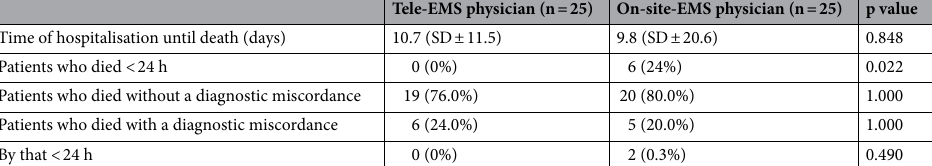
Table 2. Hospital mortality. This table shows the overall hospital mortality and the hospital mortality from patients with and without diagnostic miscordances treated initially by the tele-EMS physician in comparison to patients with diagnostic miscordance treated initially by the on-site-EMS physician. The probability of a type 1 error below 1% was considered as